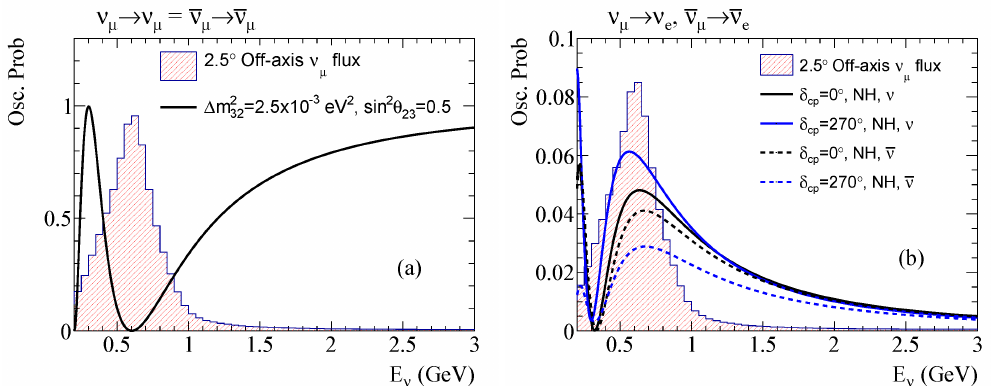
Figure 1. The spectrum of neutrinos passing through the T2K far detector, peaking at approximately 0.6 GeV due to the 2.5 ◦ off axis angle, is compared with the energy dependence of the muon–neutrino oscillation probabilities. ( a ) The muon–neutrino survival probability is near zero at the peak of the neutrino spectrum. ( b ) The electron–neutrino appearance probability is near maximum at the peak. The different curves correspond to different CP violation parameters for normal mass ordering for neutrinos and anti-neutrinos. The difference between neutrino and anti-neutrino oscillation probability for δ CP = 0 ◦ gives an indication of T2K sensitivity to mass ordering, while the difference for δ CP = 270 ◦ shows the much larger effect that would arise with maximum CP